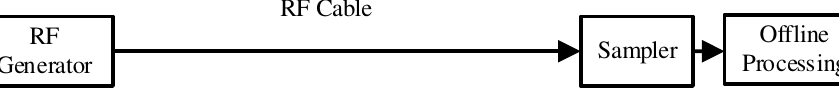
Figure 9. Measure set-up equipped for the laboratory test on the PSLR.